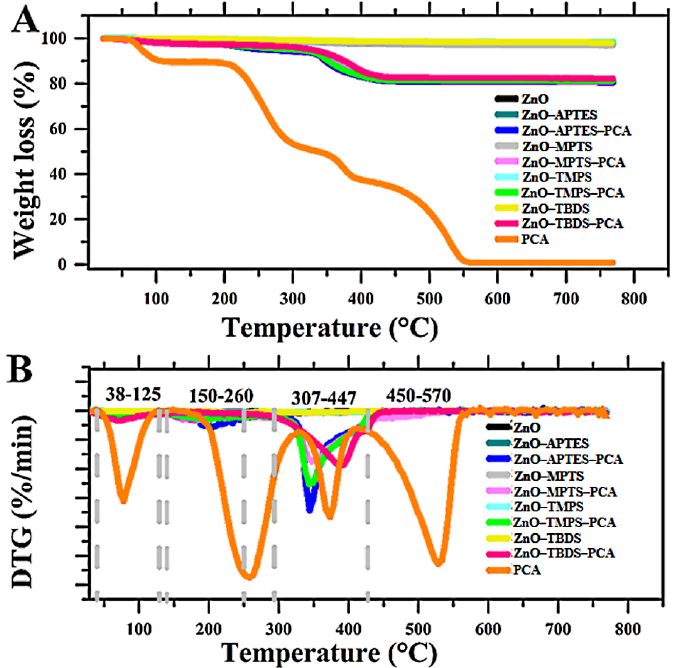
Figure 2. Thermal analysis results for materials at each stage by simultaneous thermal analysis, coupled with differential scanning calorimetry. ( A ) Weight loss measurements. ( B ) Derivative thermogravimetric (DTG) profiles. Materials were heated to 800 °C from RT at 10 °C/min in a mixture of artificial air and helium flowing through the furnace chamber. Table 1. Thermogravimetric analysis and PCA loading properties for surface-modified ZnO nanoparticles.